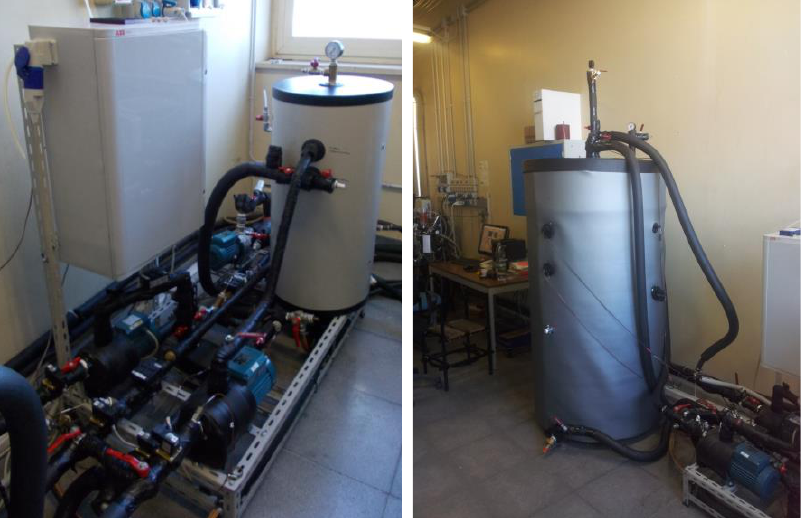
7 of 19 Figure 2. Hydraulic schematic of the TES test rig at ITAE lab: 1, electric boiler high-temperature heat source; 2, intermediate buffer; 3, TES system under examination; 4, intermediate HEX on the energy withdrawal side; 5, automatic mixing valve.